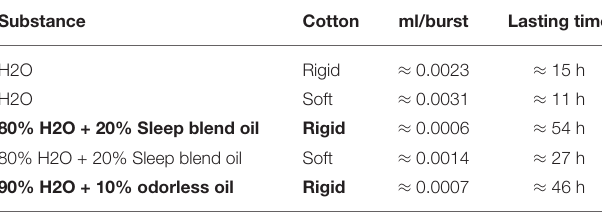
TABLE 1 | Test conditions for 10 ms bursts every 60s. Substance